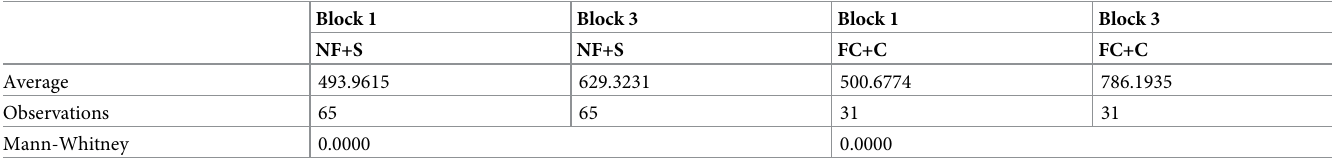
Table 5. Differences in contributions between first and third